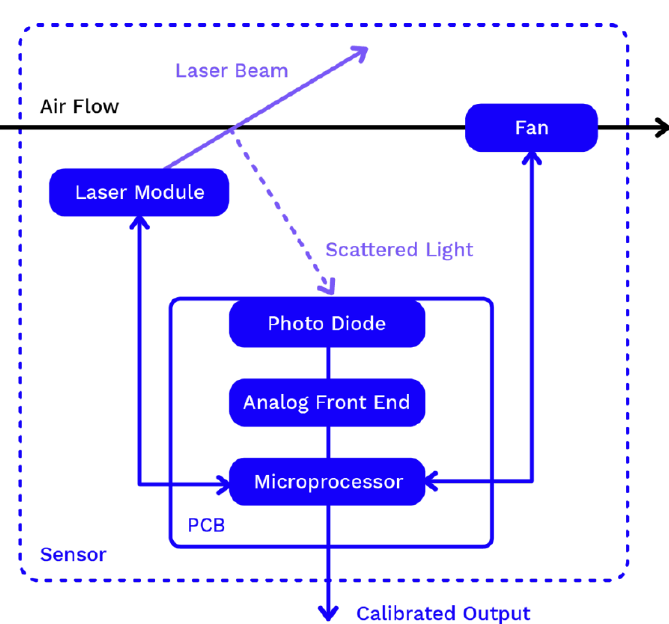
Figure 4. Sensirion SPS30 module scheme [42].